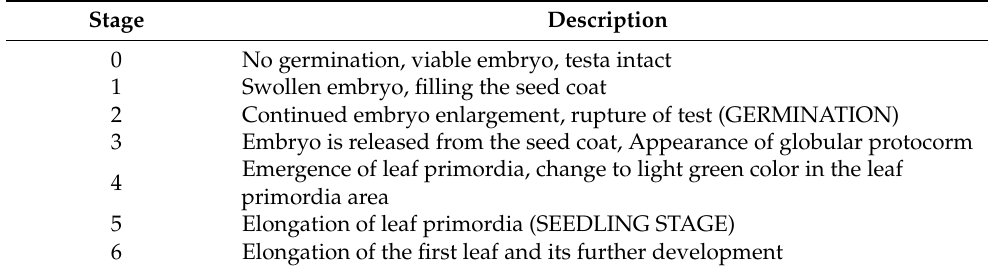
Table 2. Seed germination and developmental stages in Epidendrum geminiflorum adapted from Stewart and Zettler